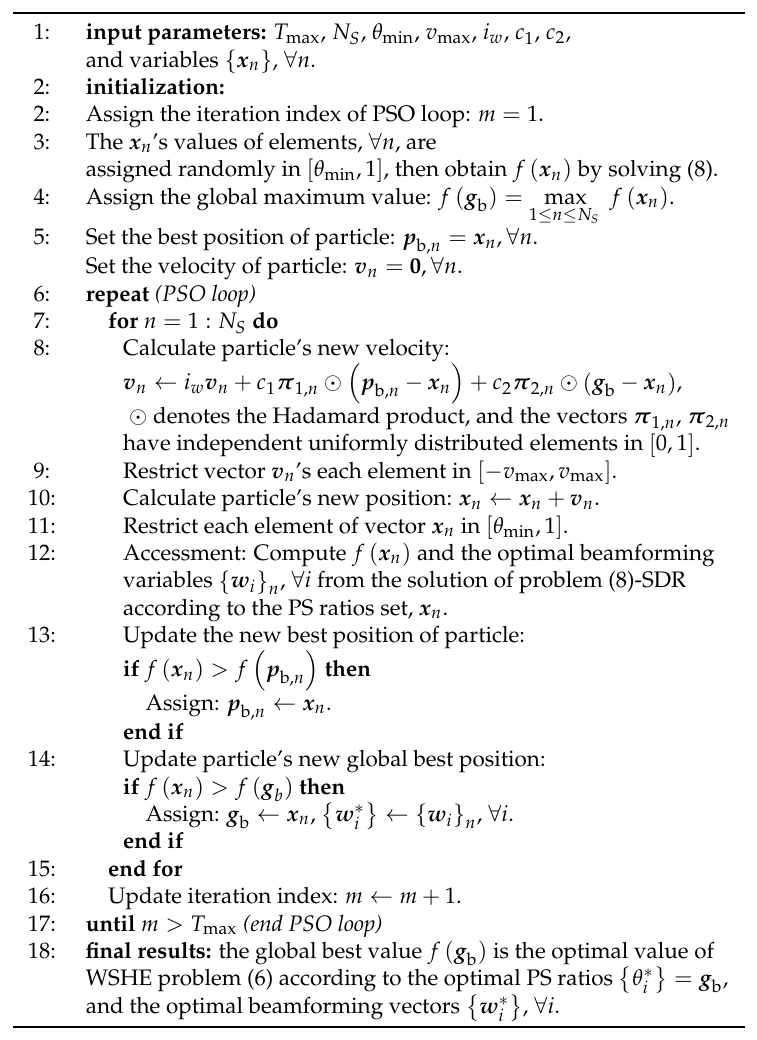
Table 2. The PSO-based algorithm for solving the WSHE problem